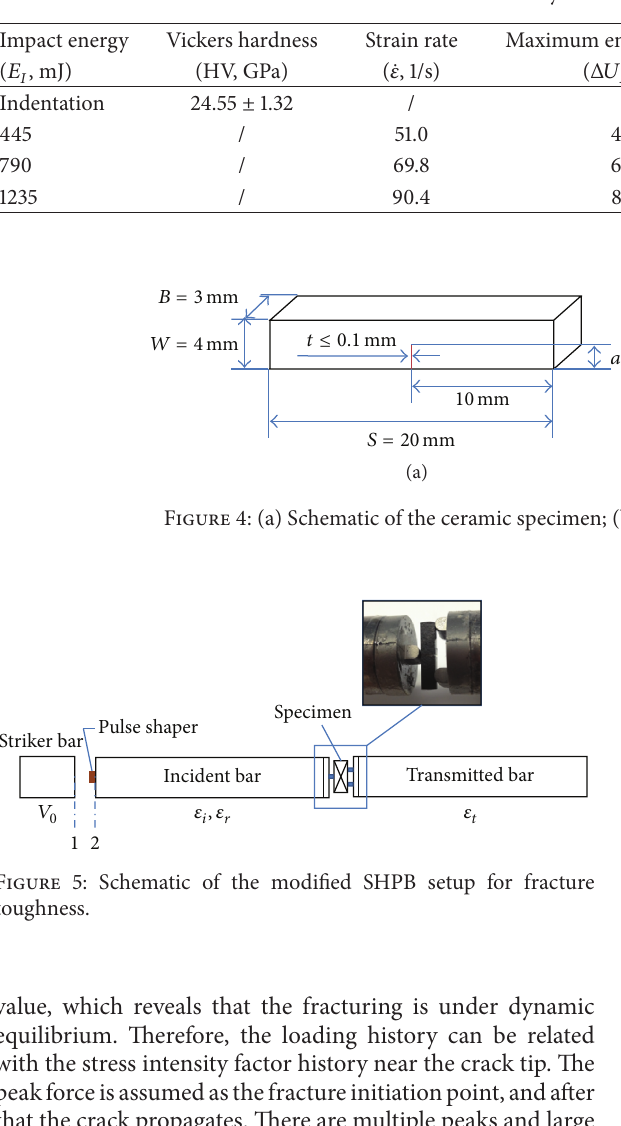
Table 2: Summary of results of fracture toughness.